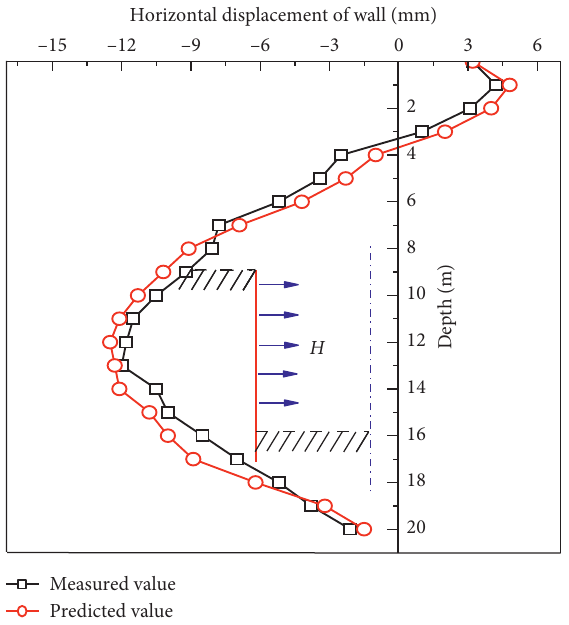
Figure 10: Maximum horizontal displacement curve of wall.